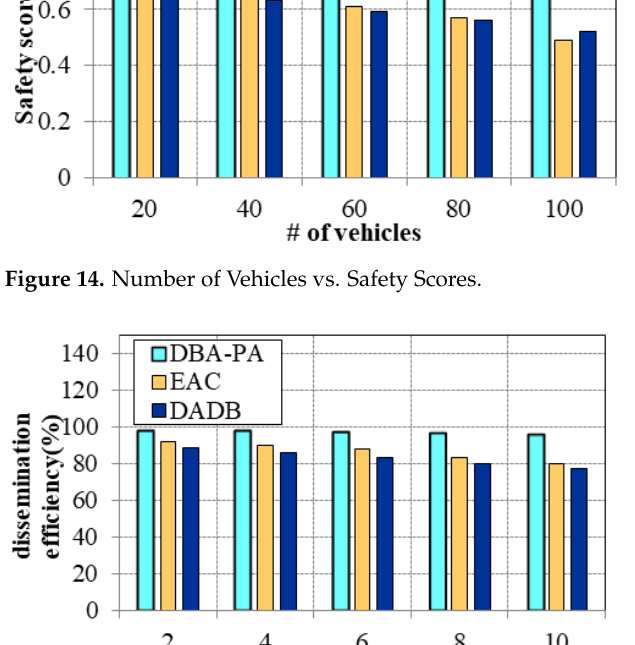
Figure 15. Number of Emergency Events vs. Dissemination Efficiency.